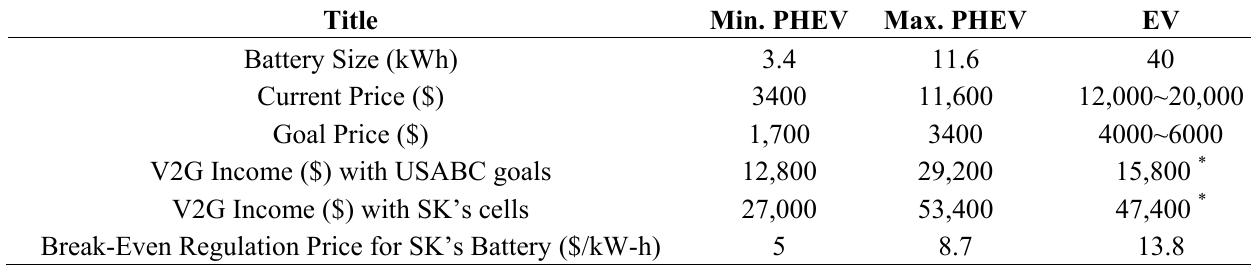
Table 3. Updated Income of V2G regulation based on the actual experiment